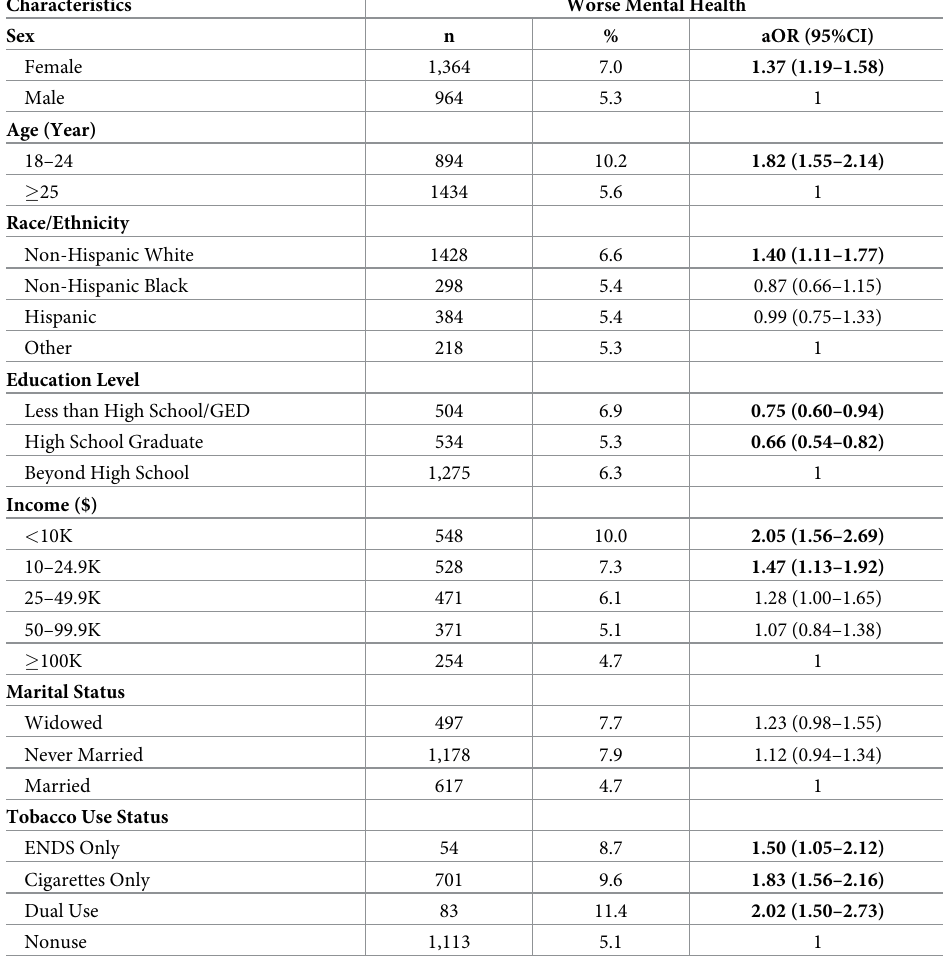
Table 5. Association between reporting worse mental health compared to 12 months ago and sociodemographic characteristics.